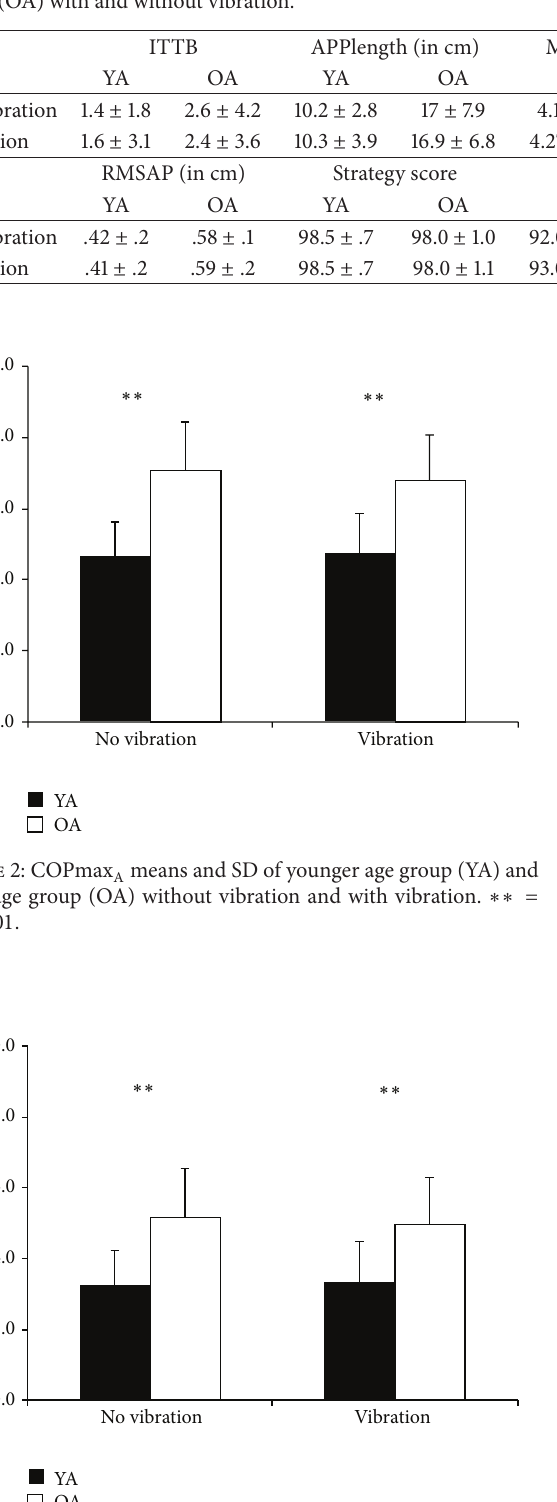
YA Figure 5: Response time means and SD of younger age group (YA) and older age group (OA) without vibration and with vibration. ∗∗ = 𝑝 < 0.01